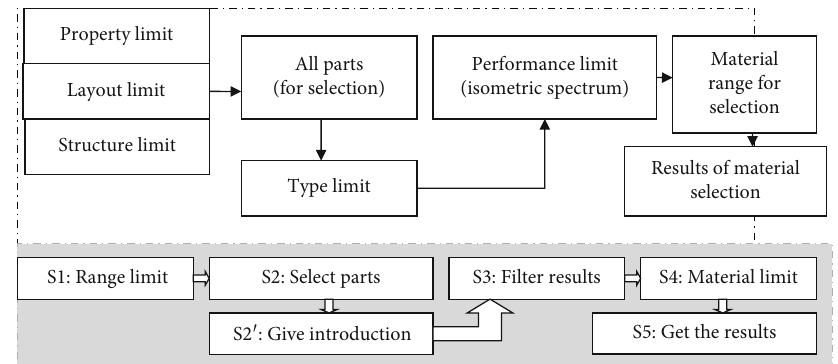
Figure 6: Methods of material selection: experience.